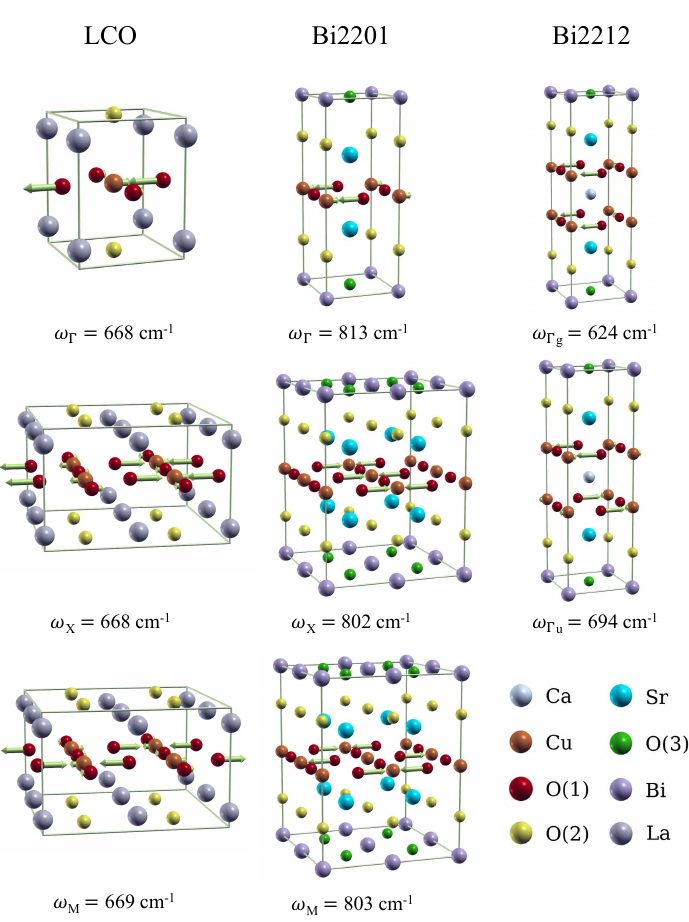
Figure 2: Cu-O bond stretching modes for La Bi Sr CaCu 2 2